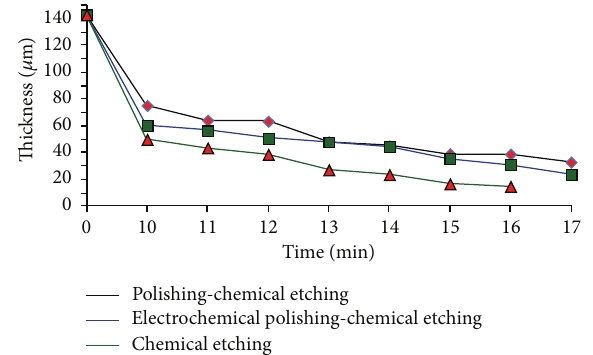
Figure 6: Titanium plates thickness curve chart of different meth- ods and etching